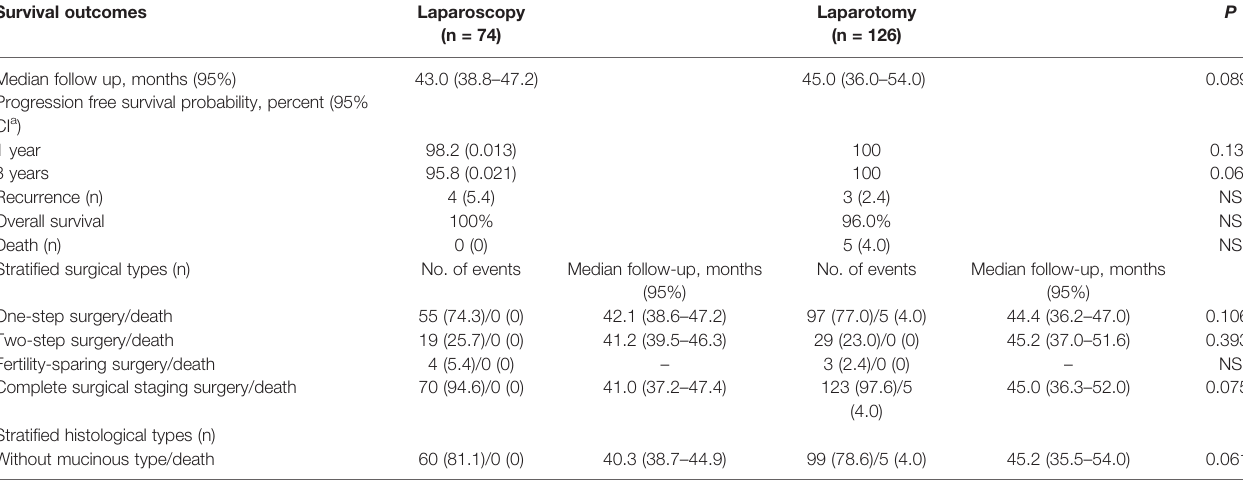
TABLE 3 | Comparison of survival outcomes and strati fi ed surgical, histological types in propensity score-matched cohort. Survival outcomes